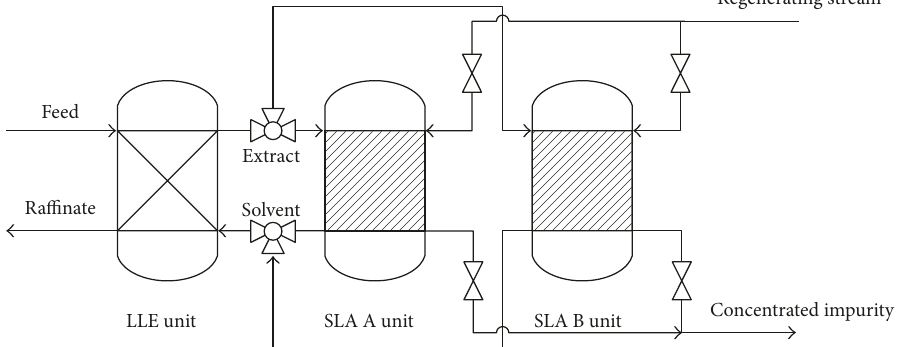
Figure 8: Flowsheet of extraction column coupled to a set of twin adsorption columns. 𝑊 Ads = 364 kg, 𝑉 Ext = 0.15 m 3 .